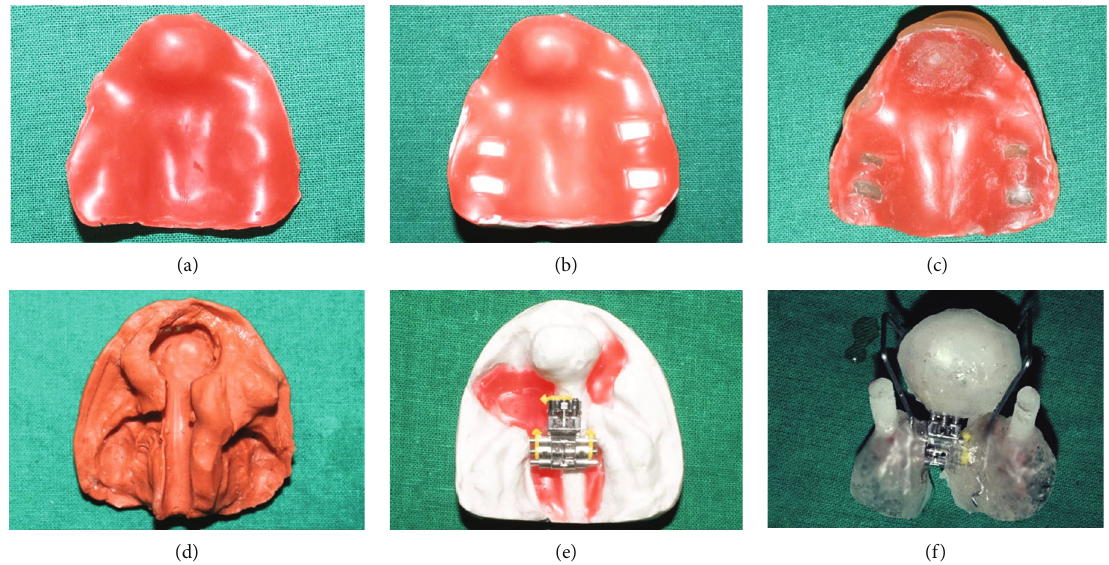
Figure 2: Steps in appliance fabrication (a) Primary wax impression. (b) Primary cast with wax spacer and tissue stops. (c) Special tray. (d)